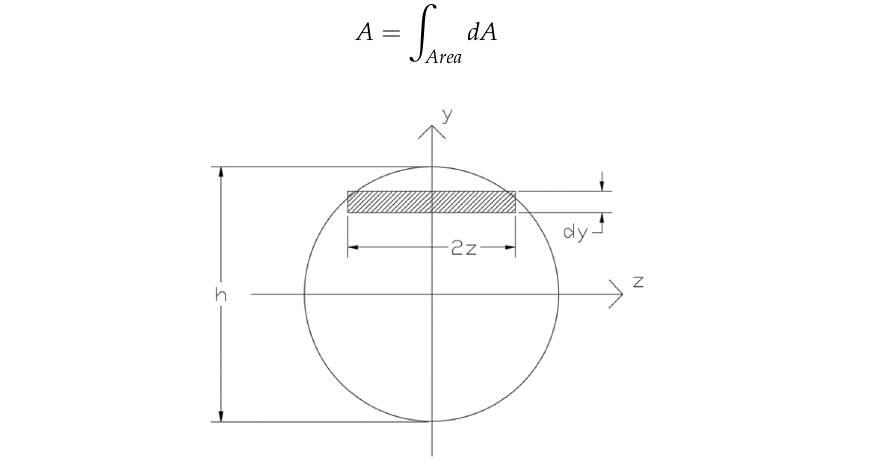
Figure 4. Cross-section of a beam.